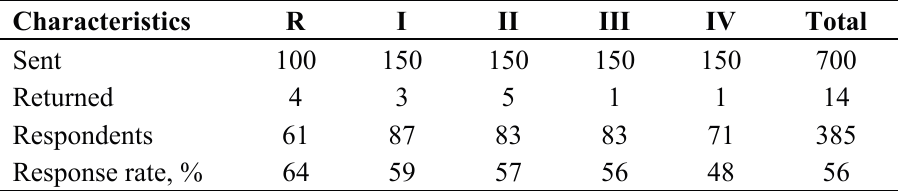
Table 2. Questionnaire administration and